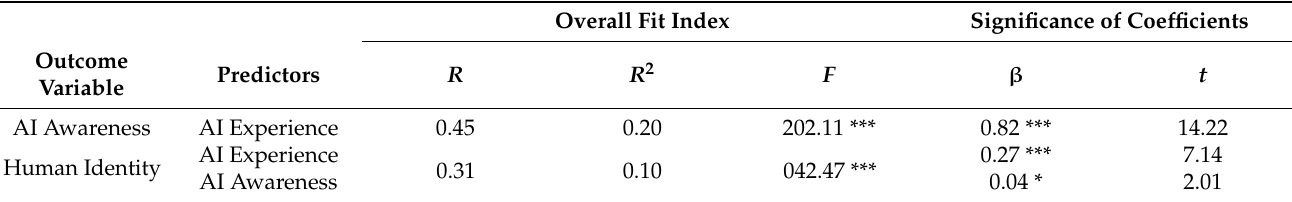
Table 4. Regression analysis of variables in the model, Study